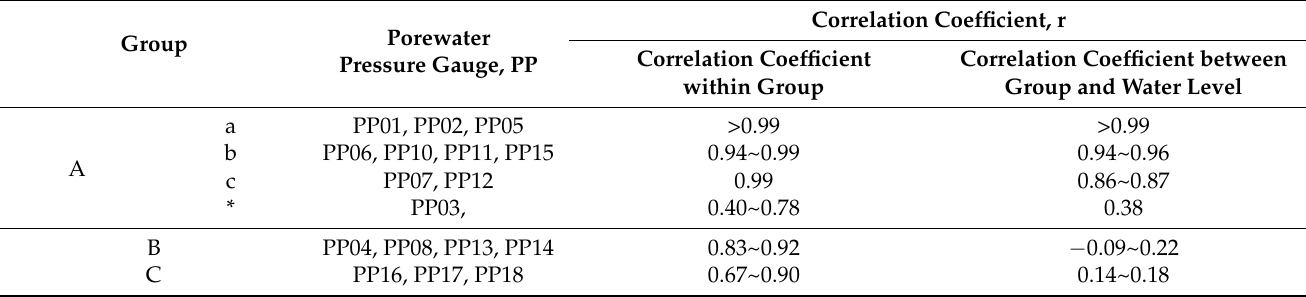
Table 4. Relationships between water level and porewater pressures in the groups. Correlation Coefficient, r Group Porewater Correlation Coefficient Correlation Coefficient Pressure Gauge, PP